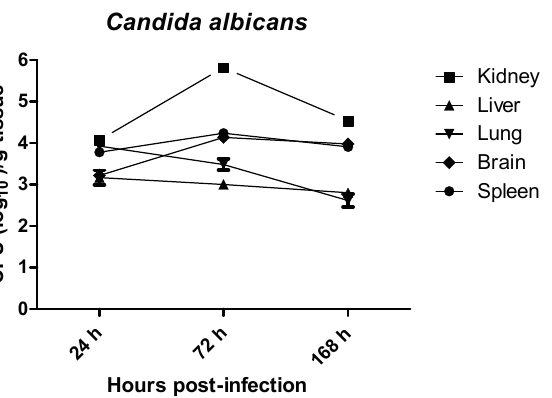
Figure 2. Red blood cell (RBC) and haemoglobin (Hb) counts of mice systemically infected with C. albicans (5 × 10 5 organisms/mouse). At specific time intervals post infection, blood was drawn from mice and subjected to blood analysis. Results